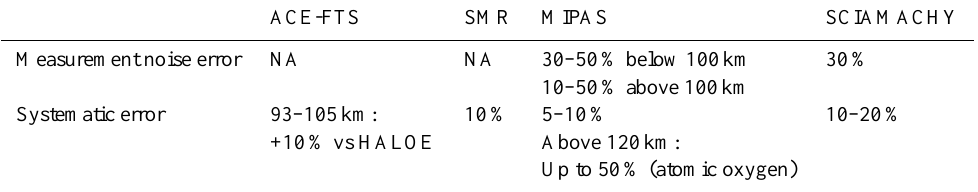
Table 2. Uncertainty estimates; see text for